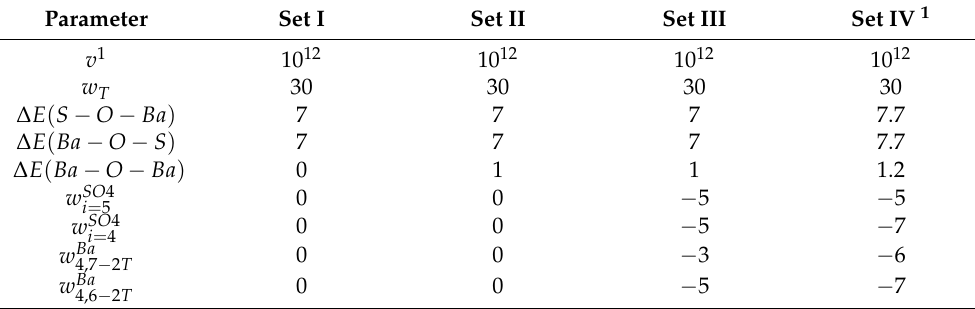
Table 1. Parameter sets for the Kinetic Monte Carlo model of barite dissolution; all parameters are provided in kT units, except v , the reaction attempt frequency factor, which is given in Hz.